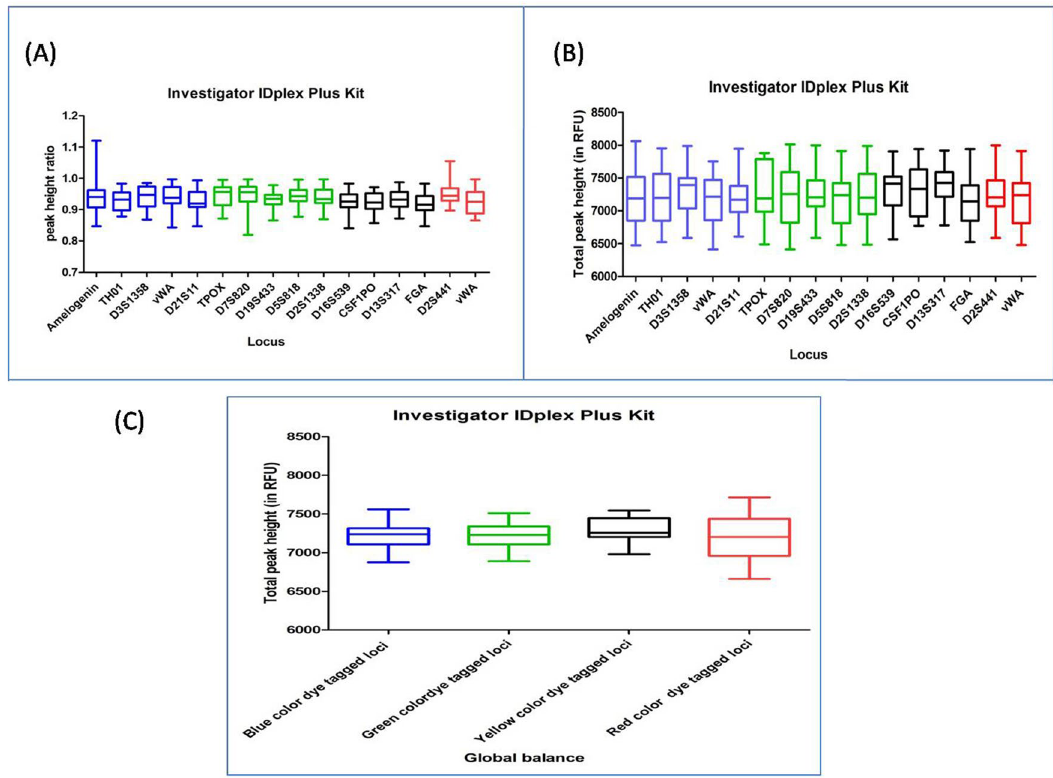
Figure 6. Quality assessment of DNA profile by Dunn’s multiple comparison test for the INVESTIGATOR IDPLEX PLUS KIT ( A ) Total peak height ( B ) Peak height ratio ( C ) Global